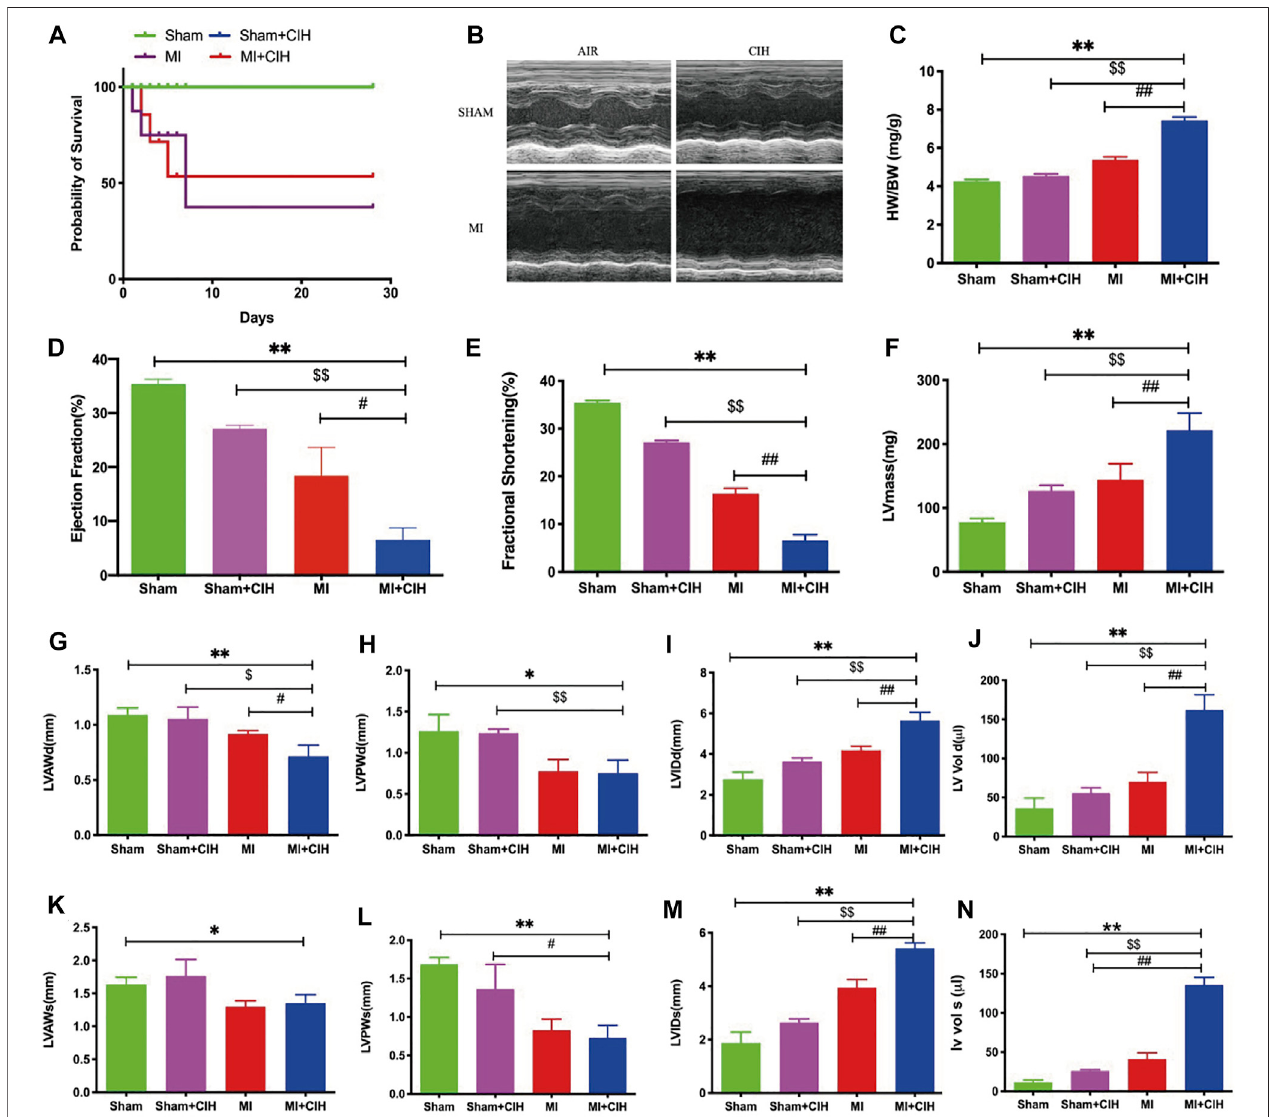
FIGURE 1 | CIH increased post-MI cardiac injury and reduced survival. The effect of CIH upon survival and LV function was determined 28 days after MI. WT mice weresubjectedtoMIorMIwithCIHoperation. (A) Survivalcurve( p =.0275). (B) Cardiacfunctionwasexaminedbyechocardiography,andfourrepresentativesetsofleft ventricular M-mode echocardiography images were displayed. (C) Statistics of HW/BW. (D – N) Quanti fi cation of EF, FS, LVmass, LVAWd, LVAWs, LVPWd, LVPWs, LVIDd, LVIDs, LV Vol-d, and LV Vol-s, from the echocardiographic analysis. n = 6 – 8/group, SHAM vs. MI + CIH: * p < .05, ** p < .01; SHAM vs. MI + CIH: $ p <